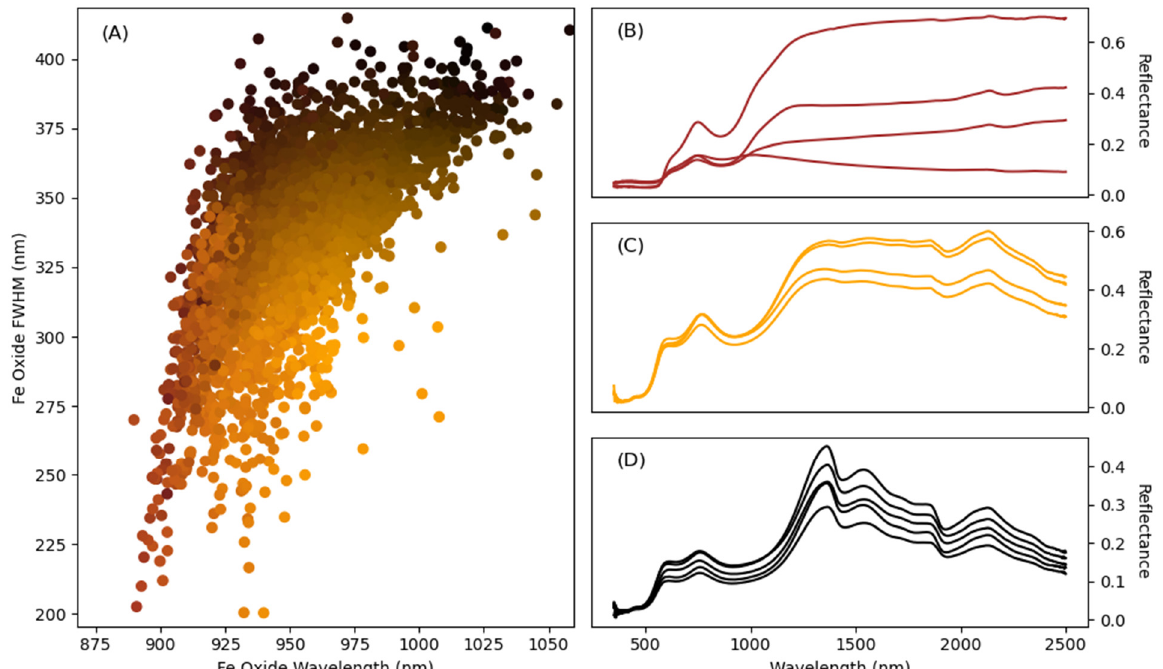
Figure 13. The first column is a false colour image of the downhole estimated mixing ratios where the RGB values are determined from the relevant endmember mixing ratio and are colored as per the mixing ratio columns (columns 2–4) of hematite (brown), ochreous goethite (orange), and vitreous goethite (black). In columns 2–4 the mixing ratios are averaged over 1 m for the drillcore and coloured by their respective endmember colours. Column 5 shows colour images of the trays at specific locations in the drill core that show the range of ochreous and vitreous goethite and hematite. The depths the core trays span are shown in colored text above each tray with their locations corresponding to the coloured horizontal bar in columns 2–4.